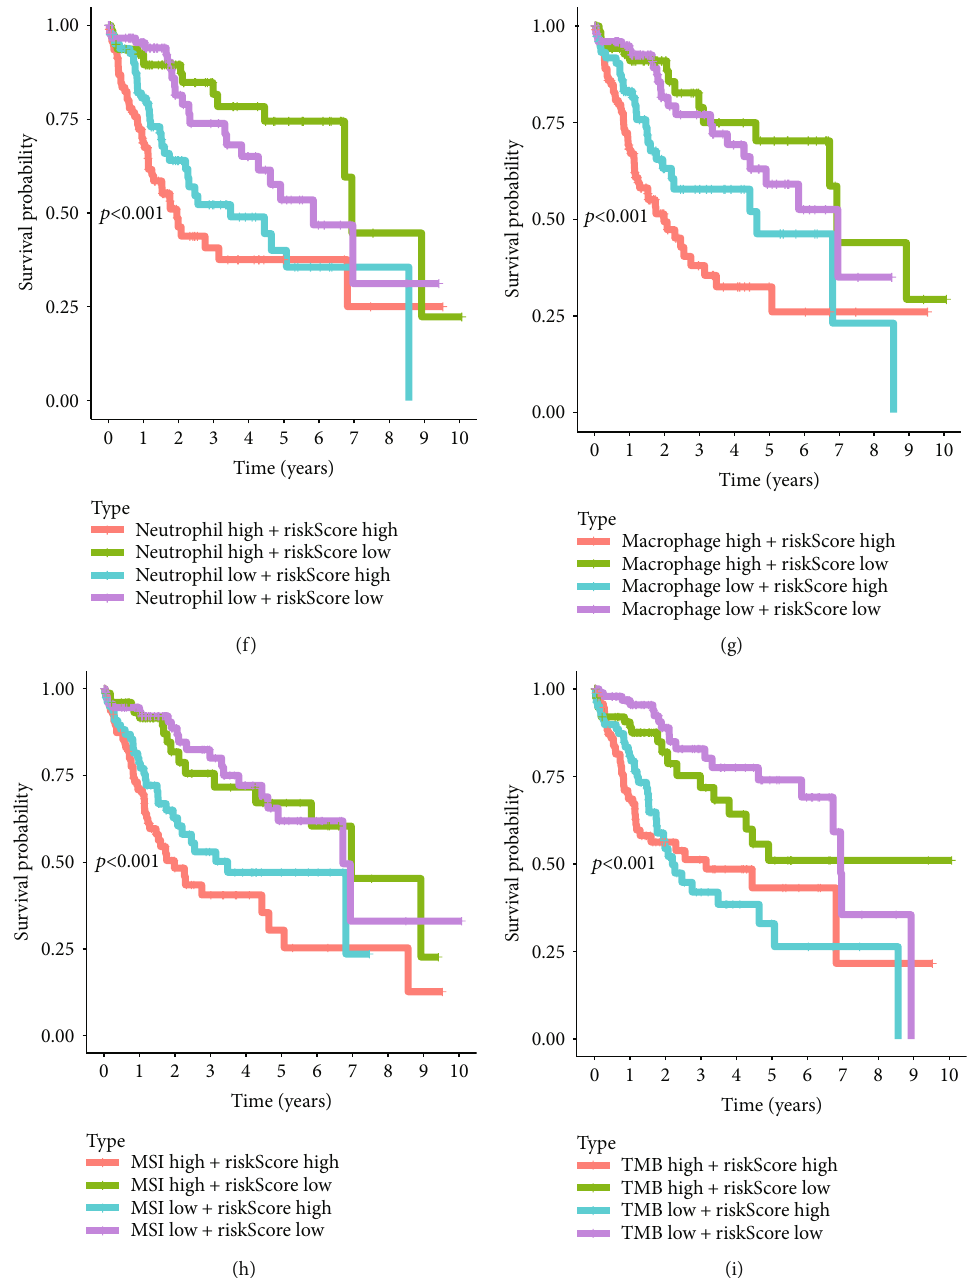
Figure 5: Survival analysis of HCC patients based on the risk score, immune cell in fi ltration patterns, MSI, and TMB. (a) Correlation analysis between risk score and immune cell, TMB, and MSI. (b – i) Two-factor survival analyses of risk score and immune cell in fi ltration indicators including CD8 T cell (b), B cell (c), dendritic (d), CD4 T cell (e), neutrophil (f), macrophage (g), MSI (h), and TMB (i). MSI: microsatellite instability; TMB: tumor mutation